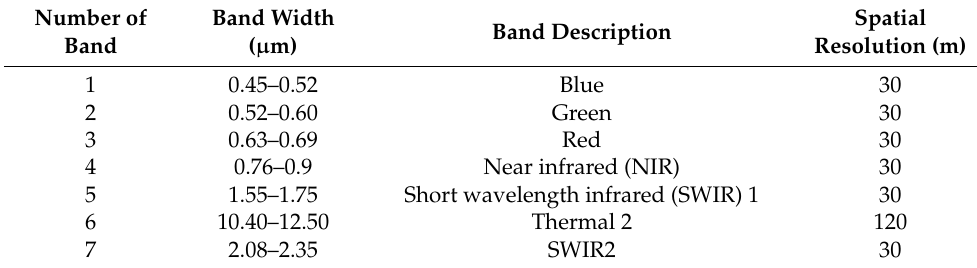
Table 2. Bandwidth and spatial resolution of the Landsat 5